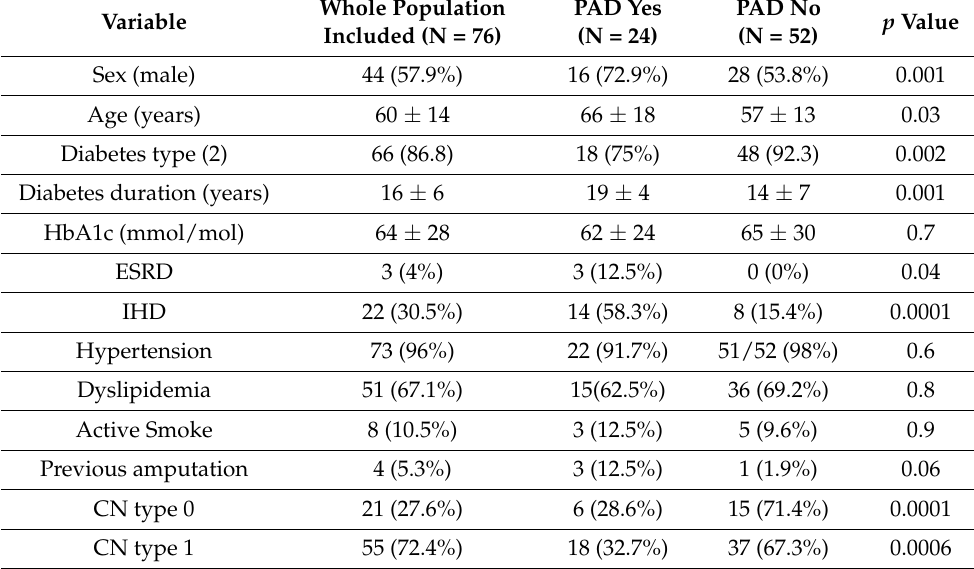
Table 2. Baseline demographic and clinical characteristics.